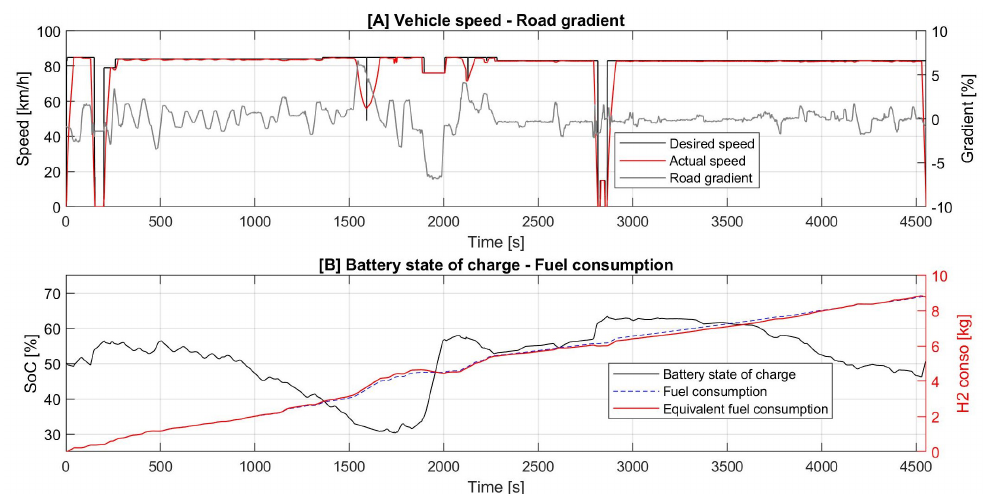
Figure 6. Simulation results for HD FCEV truck running on VECTO Longhaul cycle: ( A ) distance based desired and actual vehicle speed, road gradient; and ( B ) battery state of charge, cumulative and equivalent H 2 fuel consumption.